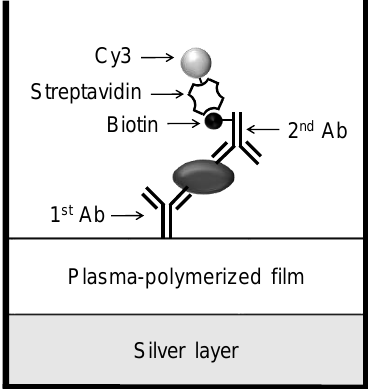
AbBiotinCy3 Streptavidin 2 nd film1 st Ab Plasma-polymerized Silver layer Figure 1. Schematic diagram of a sensitive sandwich immunoassay using a multilayered microplate.